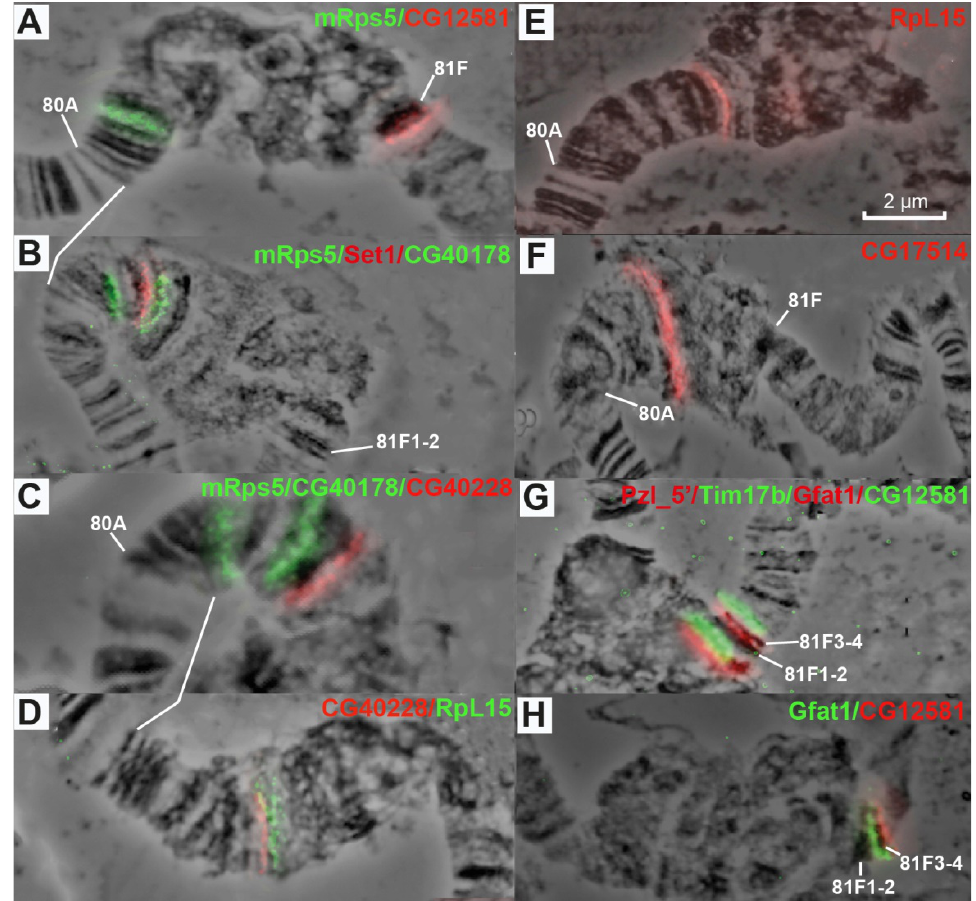
Figure 8. Localization of probes on chromosome 3 heterochromatin: mRsp5 and CG12581 (80F and 81F ( A )), mRsp5/Set1/CG40178 (80F and Plato Atlantis ( B )), mRsp5/CG40178/CG40228 (80F and Plato Atlantis ( C )), CG40228/RpL15 (Plato Atlantis ( D )), RpL15 (Plato Atlantis ( E )) (taken from [64]), CG17514 (Plato Atlantis ( F )), Pzl_5'/Tim17b/Gfat1/CG12581 (Plato Atlantis and 81F3-4 ( G )), Gfat1/CG12581 (Plato Atlantis and 81F3-4 ( H )). The genotype in all figure parts is Rif1 1 . Scale bar value is the same for every figure.